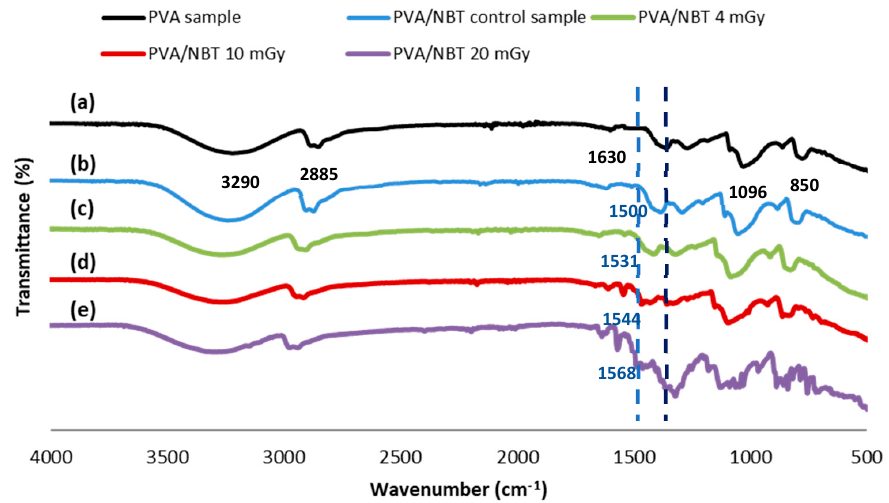
Figure 4. Dose–response curve based on UV-Vis absorption capacities at λ max for PVA/NBT films exposed at various X-ray doses.